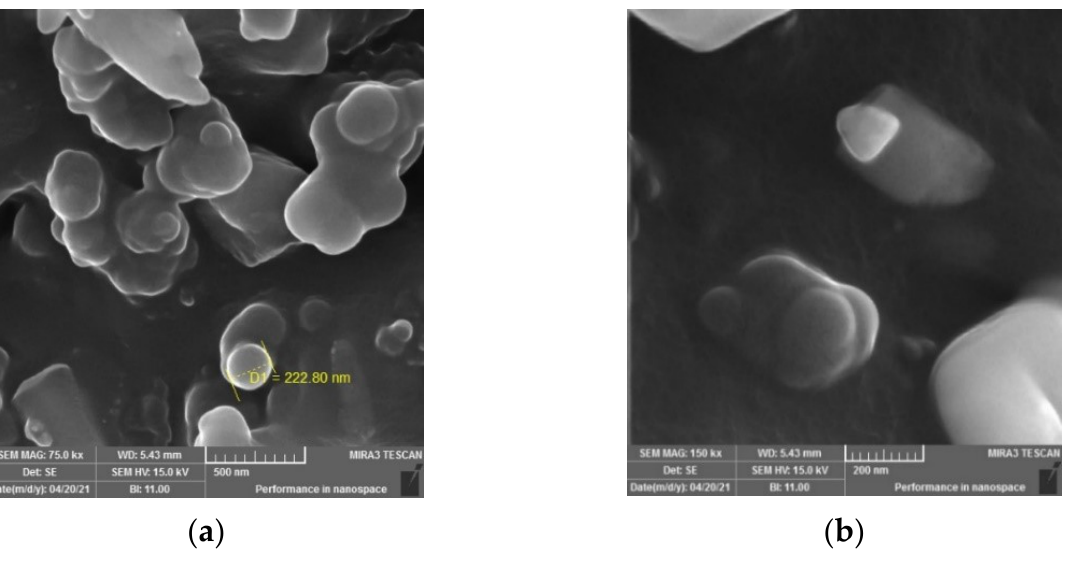
Figure 12. SEM images of pyrolytic carbon black with different magnifications ( a ) 75k, ( b ) 150k. The BET measurement (Table 6) of pyrolytic CB shows the Langmuir surface area is 46.671 m 2 /g, which is high when compared with the surface area of pristine tire particles. Even the t plot (Table 6) shows a high surface area (i.e., 36.414 m 2 /g), which means